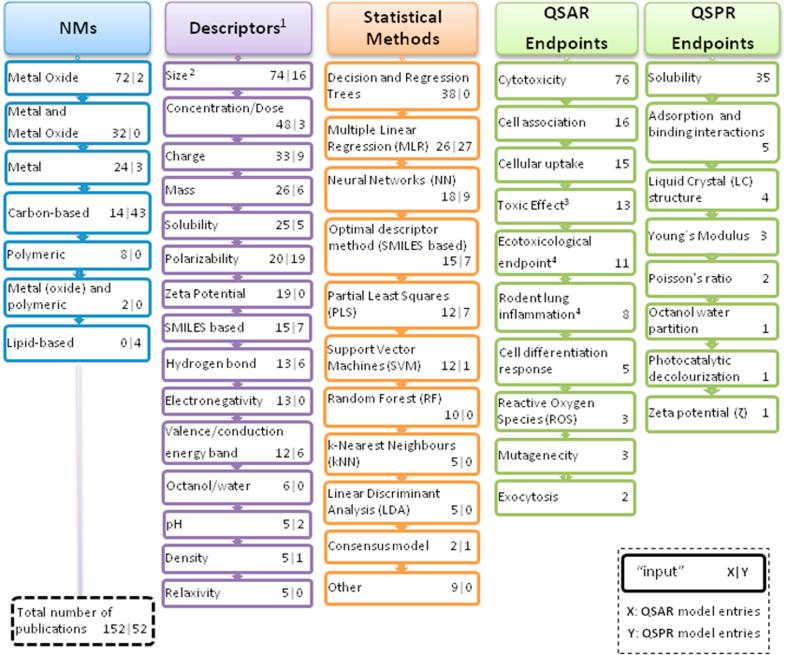
Summary of the landscape of QSAR and QSPR models. Numbers assigned to QSAR/QSPR models quantify the specific weight of each element within the same type of model. For example, the number of models applicable to carbon-based MNs corresponds to 14 and 43 for QSAR and QSPR models, respectively. The total numbers of QSAR and QSPR models in the inventory are 152 and 52, respectively). 1Most representative descriptors were included. 2Size descriptor includes size, radius, diameter, length, volume and aggregation/agglomeration. 3Endpoint defined by the author. 4Endpoint defined to group highly associated endpoints.